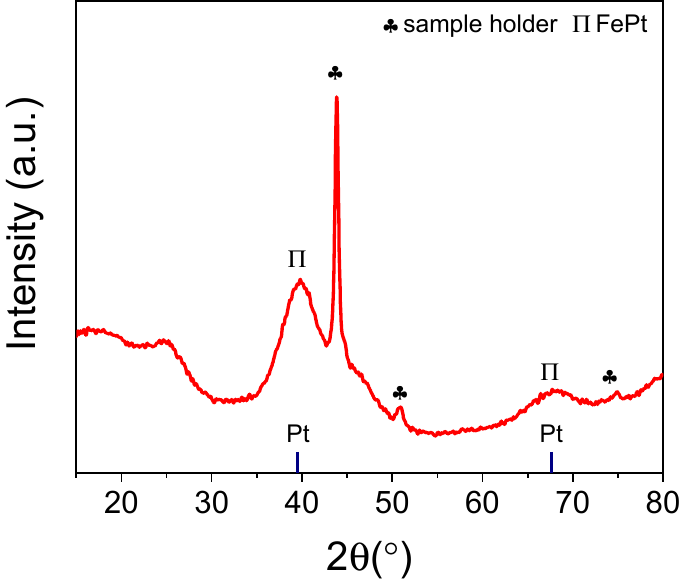
Figure 2. XRD pattern of as-synthesised FePt/VC.